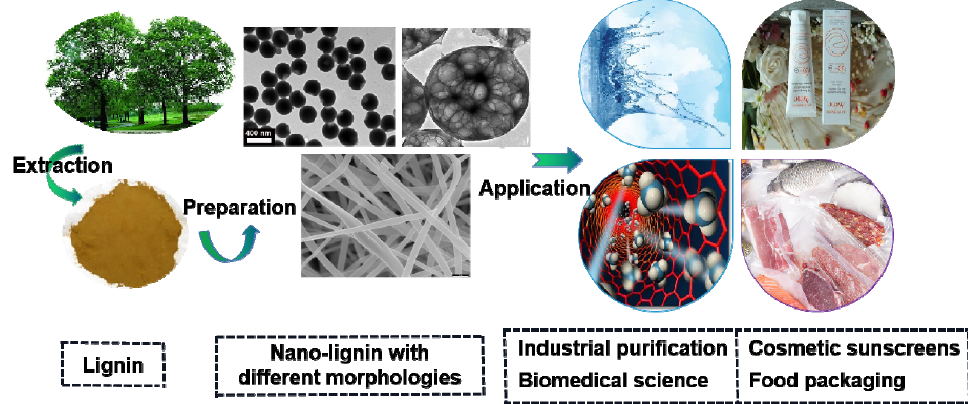
Figure 2. Nanolignins with different morphologies and their applications in different fields.